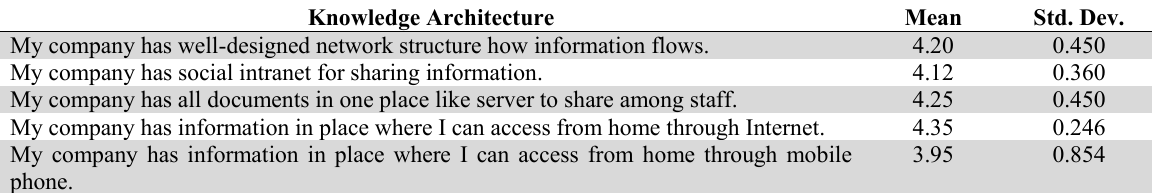
Mean and Standard Deviation for “Knowledge Architecture” Knowledge